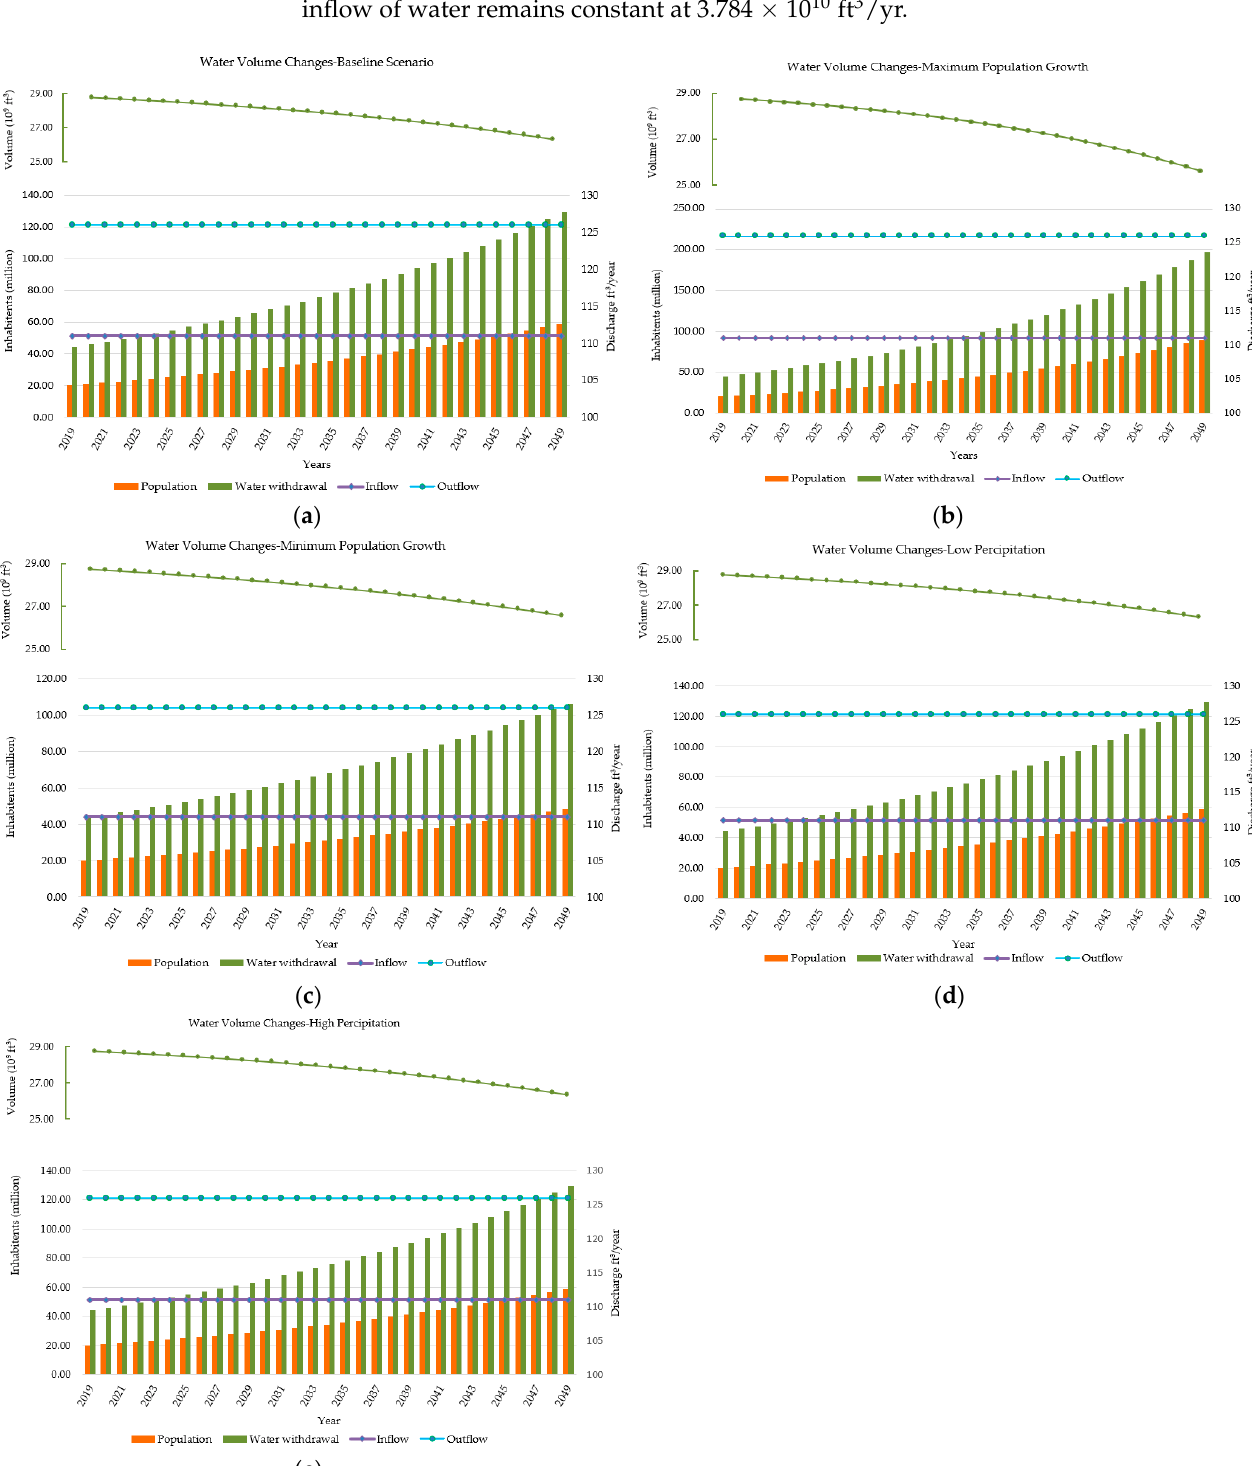
Figure 9. Simulated water volume changes in Keenjhar Lake with scenario ( a ) base line; ( b ) maximum population growth; ( c ) minimum population growth; ( d ) high rainfall; ( e ) low rainfall.